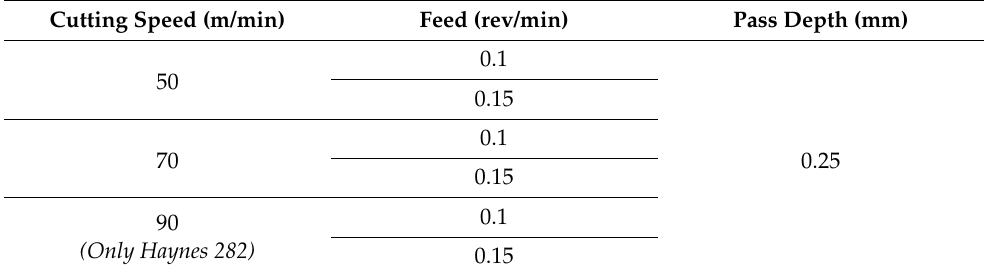
Table 3. Conditions for turning